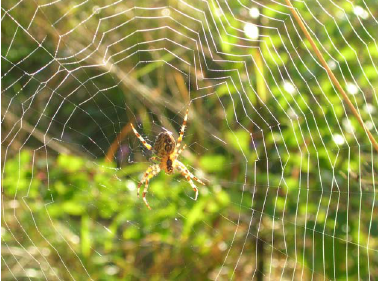
Figure 1. An Araneus spider in its orb web. Image credit: Anna